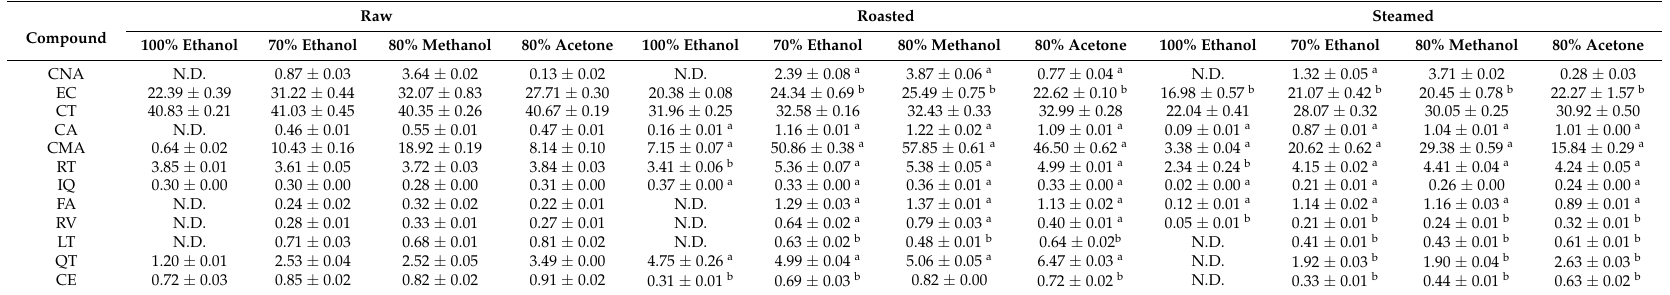
Table 3. Average levels of 12 phenolic compounds in peanut extracts collected from four Korean